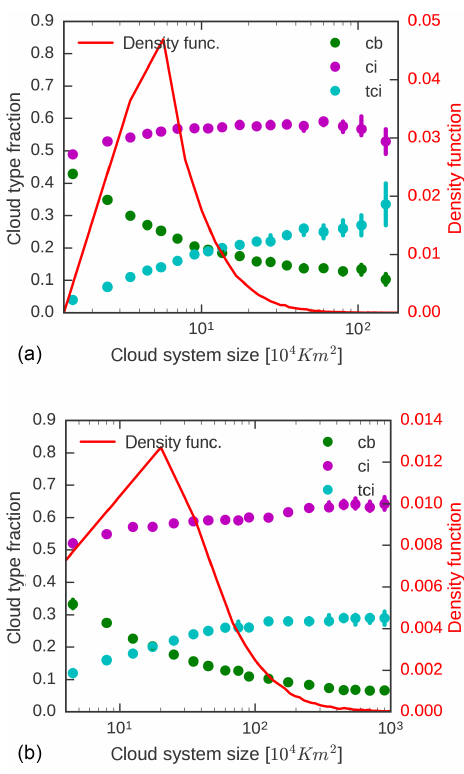
Figure 6. Median values and standard errors of fraction of convec- tive core (green), thick (magenta) and thin (cyan) anvil as a function of cloud system size. In red are cloud system size density function distributions for (a) single-core and (b) multi-core systems (AIRS data, 2003–2015).